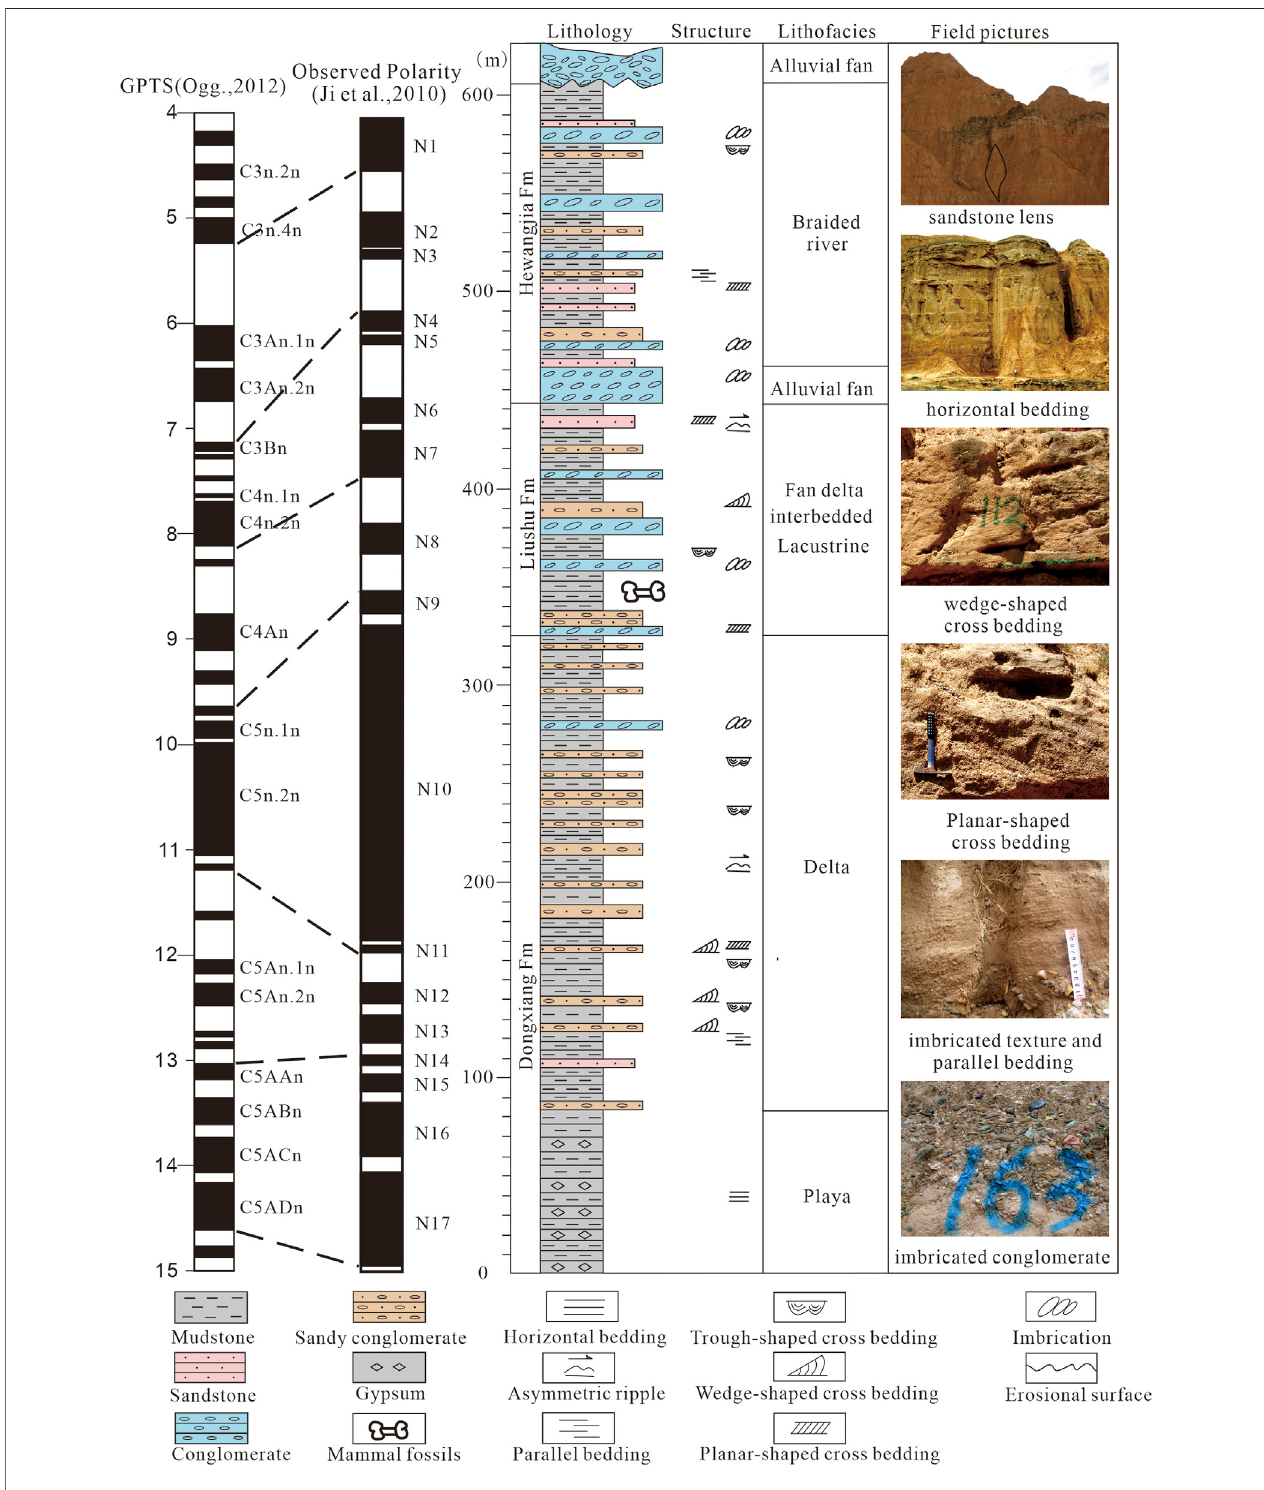
FIGURE2| Lithology,sedimentaryfaciesand magnetostratigraphicframework oftheXigousection intheXunhuaBasin.Dashed linesshowthecorrelationsofthe observed magnetic polarities (Ji et al., 2010) with the geomagnetic polarity time scale (GPTS; Ogg, 2012).